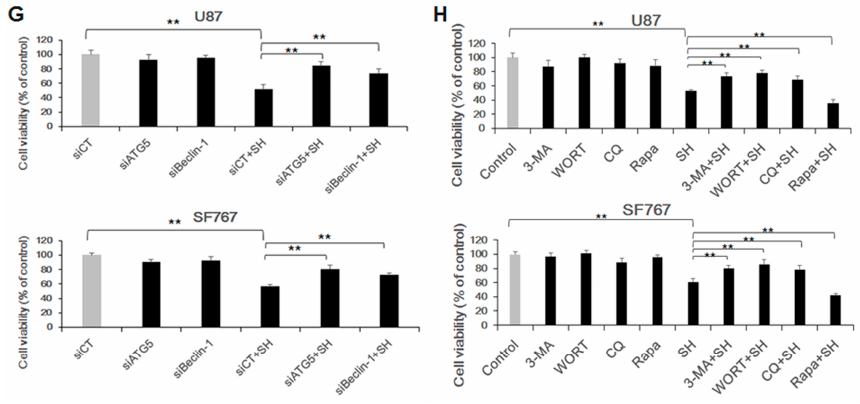
Figure 2. SH inhibits human glioblastoma cell viability through autophagy. ( A ) Representative transmission electron micrographs indicating the ultrastructure of U87 and SF767 cells. Various types of autophagic vesicles (arrowheads) are found within the cytoplasm in the two cell lines treated with SH (0.5 mM) for 24 h; ( B ) After 24 h of SH treatment (0.5 mM) in the presence or absence of 3-MA, the two cell lines were stained with AO and observed via confocal microscopy. AO produces red fluorescence in acidic autophagic vacuoles, and green fluorescence in cytoplasm and nucleus; ( C ) After 24 h of SH treatment (0.5 mM) in the presence or absence of 3-MA, the two cell lines were stained with MDC and imaged via confocal microscopy; ( D ) Effects of SH on LC3B-II levels in human glioblastoma cells. U87 and SF767 cells were treated with SH (0.5 mM) and/or CQ for the indicated times; ( E ) Efficiency of Beclin-1 and ATG5 knockdown. ( F ) Effects of ATG5 or Beclin-1 siRNA on SH-mediated autophagy. U87 and SF767 cells were transfected with a no-target control siRNA (siCT), ATG5 siRNA (siATG5), or Beclin-1 siRNA (siBeclin-1) for 24 h and then treated with or without SH (0.5 mM) for another 24 h; ( G ) Effects of ATG5 or Beclin-1 siRNA on SH-mediated inhibition of human glioblastoma cell proliferation; ( H ) Effects of autophagy inhibitors or activators on the SH-induced inhibition of human glioblastoma cell growth. Each image is representative of n = 3 experiments. The results shown in ( D – F ) are representative Western blots, n = 3, and β -actin served as the loading control. All data are shown as the mean ± SEM, n = 3. ** p < 0.01, versus the control or SH treatment